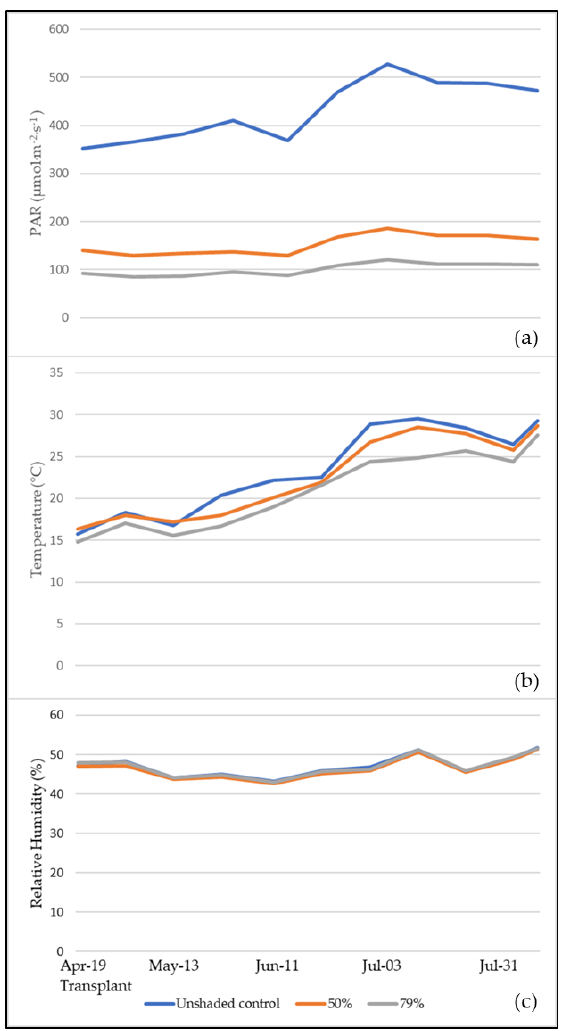
Figure 1. Seasonal trends corresponding to 50% and 79% shading nets and unshaded control under tunnels of: ( a ) photosynthetic active radiation (PAR); ( b ) temperature; ( c ) relative humidity. The dates reported on the x axis correspond to the end of each cropping season in the unshaded control, from the first (13 May) to the fourth (31 July).